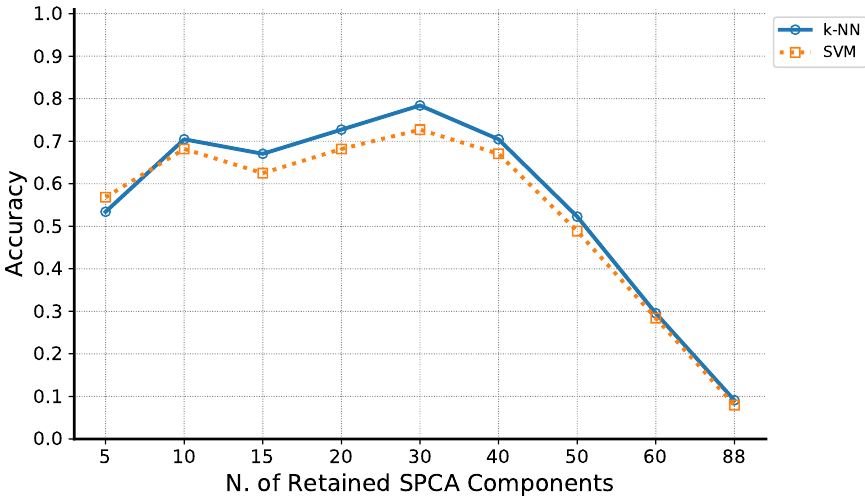
Figure 7. Plot of the accuracy obtained with SVM and k-nearest neighbors (k-NN) varying the number of retained SPCA components. Each value is the average of the classification results validated using the leave-one-out